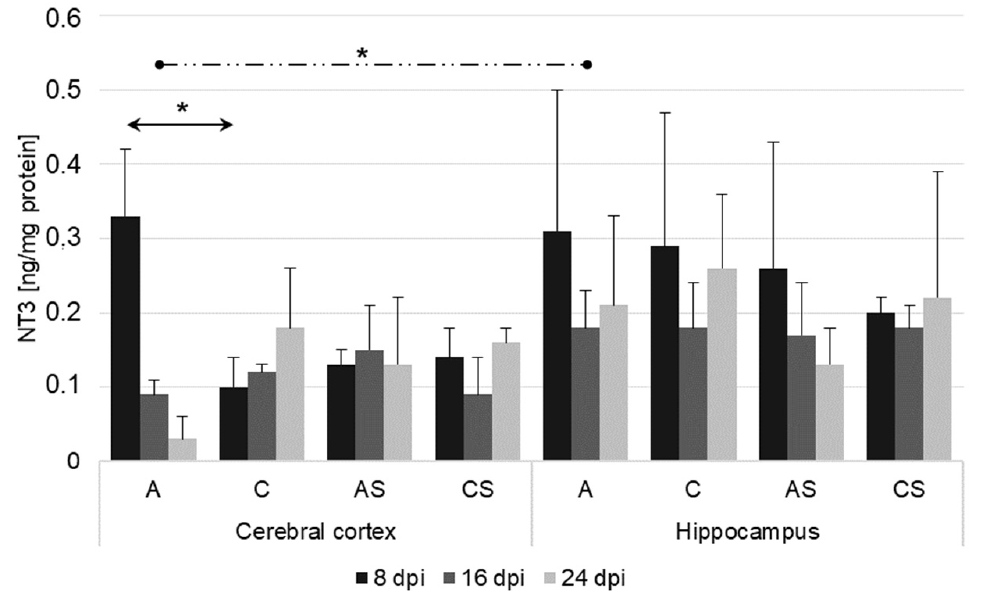
Figure 3. Neurotrophin-3 level (ng/mg protein) in the cerebral cortex and hippocampus in control and infected groups at 8, 16, and 24 days after Acanthamoeba spp. infection (dpi). Data present means ± SD for 6 independent experiments. C, immunocompetent uninfected mice; CS, immunosuppressed uninfected mice; A, immunocompetent Acanthamoeba spp. infected mice; AS, immunosuppressed Acanthamoeba spp. infected mice; solid arrows indicate differences between infected and control mice while dashed arrows indicate differences between brain structures; * p ≤ 0.05 for the significance of difference (Mann–Whitney U